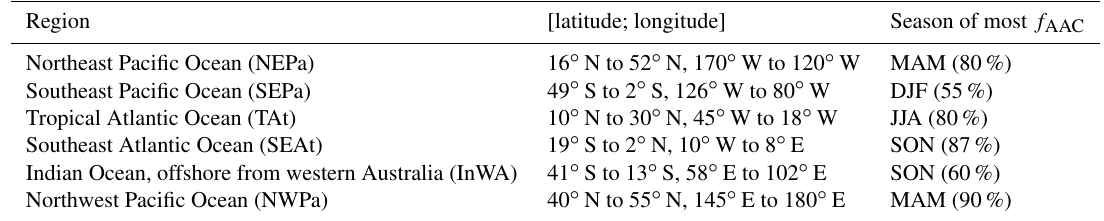
Table 5. Six regions of high AAC occurrence (see Fig. 6), their season of highest AAC occurrence and its corresponding mean f AAC value. Region [latitude; longitude]